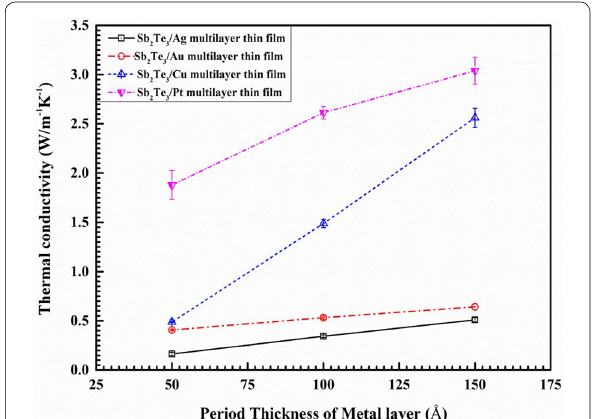
Fig. 5 Cross‑plane thermal conductivities of Sb 2 Te 3 /(Au, Ag, Cu, Pt) multilayer thin